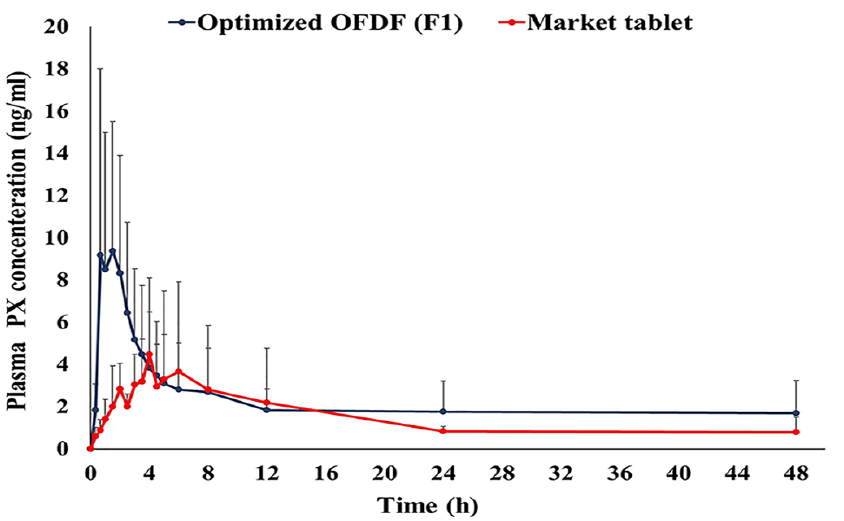
Figure 7. Mean paroxetine plasma concentration time curve after administration of the optimized OFDF (F1) and the market tablet to six healthy human volunteers. Table 5. Drug pharmacokinetic parameters after the administration of the optimized OFDF (F1) compared to the market